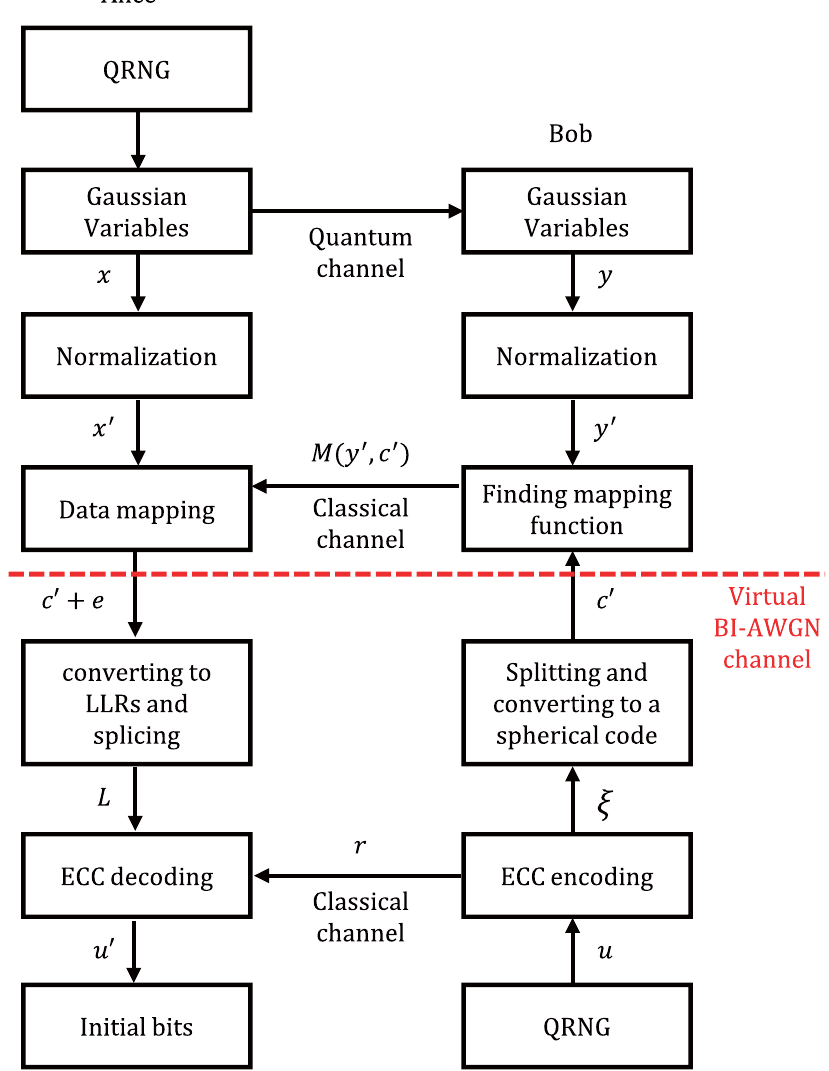
Fig. 7 Block diagram of reverse-reconciliation CV-QKD systems. The quantum channel is modeled as a virtual BI-AWGN channel, and a rate- compatible MET-LDPC code is assumed as the ECC whose rate is set to the maximum value or the capacity of the virtual BI-AWGN channel by puncturing parity